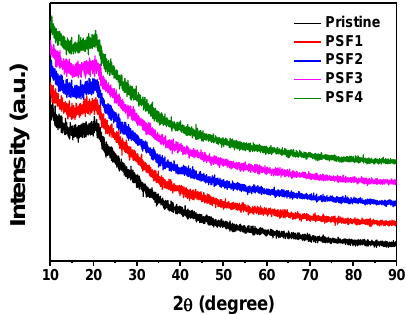
Figure 4. X-ray diffraction (XRD) patterns of different fabric samples.